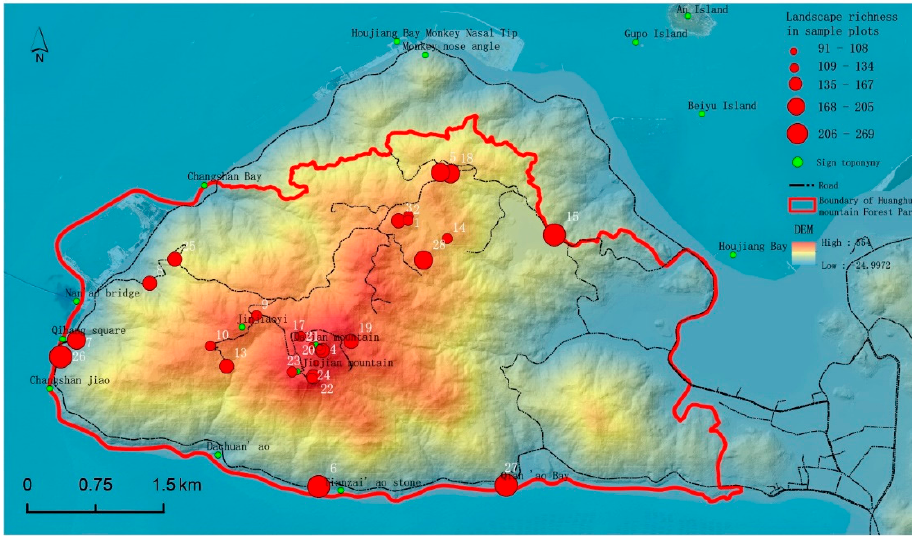
Figure 3. Hierarchical distribution of landscape richness in sample plots.